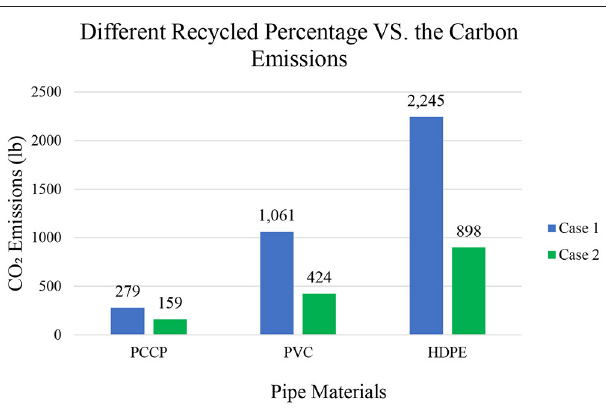
FIGURE 6 | Different recycled percentage VS. Carbon